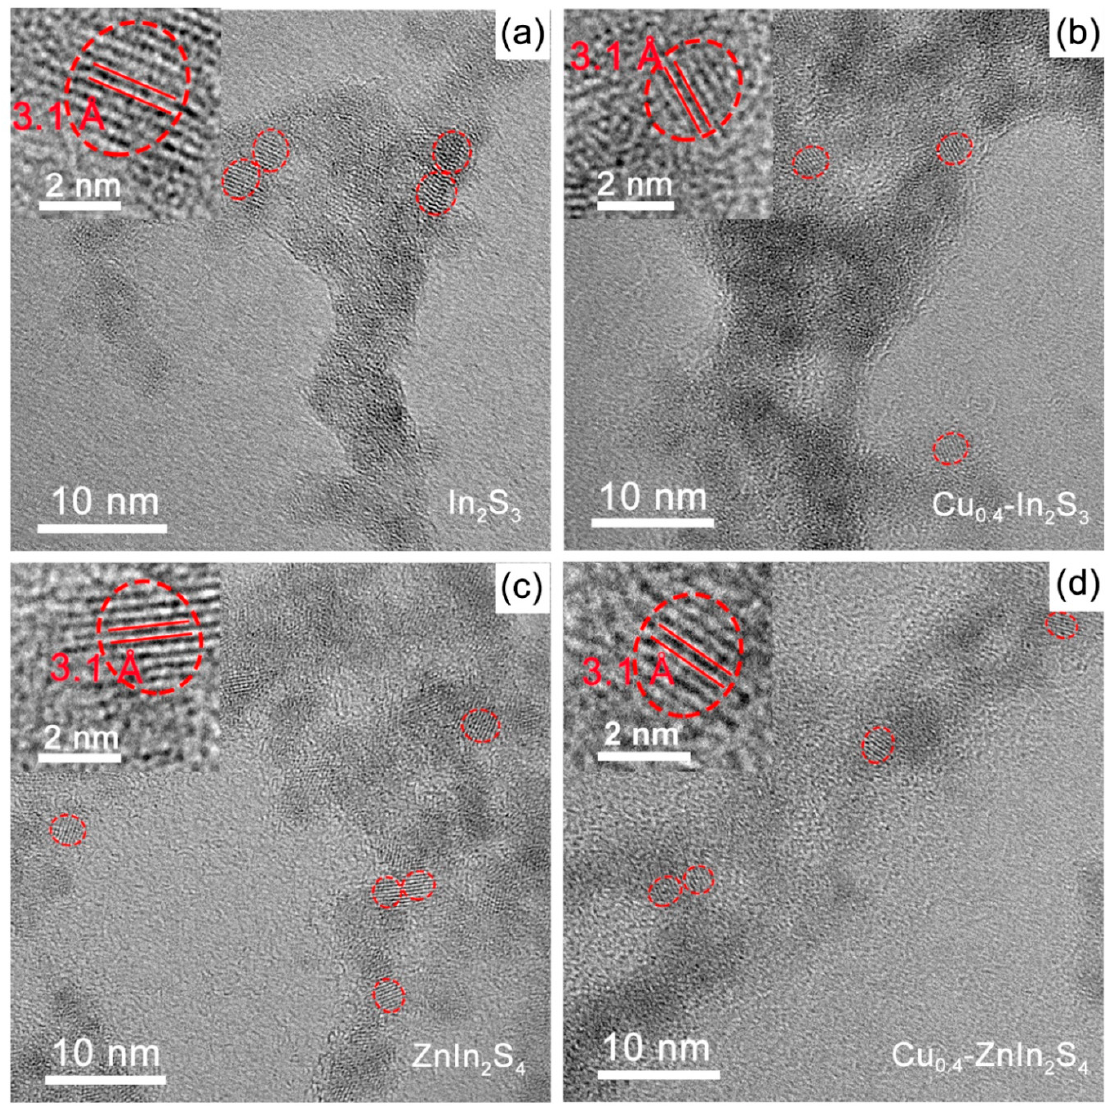
Figure 2. The TEM images of ( a ) In 2 S 3 , ( b ) Cu 0.4 -In 2 S 3 , ( c ) ZnIn 2 S 4 and ( d ) Cu 0.4 -ZnIn 2 S 4 QDs. The insets show the corresponding high-resolution TEM images.